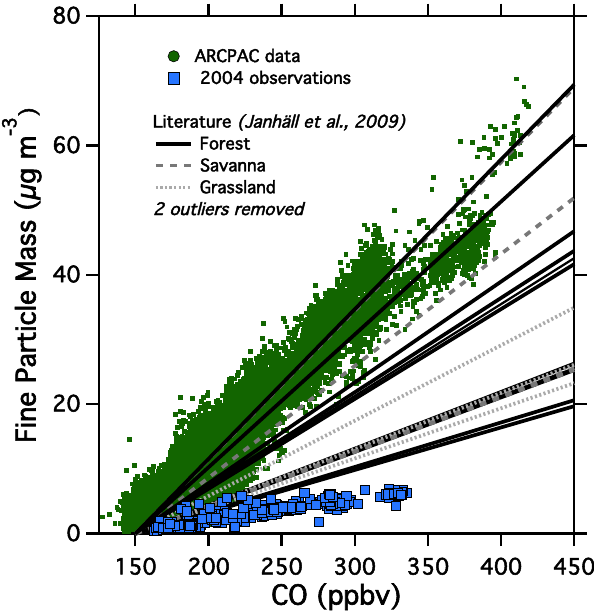
Fig. 13. Particle mass as a function of CO for all data classified as biomass/biofuel burning during ARCPAC (dots). Mass calculated from particle volume measurements and density of 1.36 determined from AMS composition measurements in BB plumes. Squares are data from a BB case in 28 July 2004 in which precipitation scav- enging occurred (de Gouw et al., 2006) with CO values adjusted to intercept the x -axis at 150ppbv to facilitate comparison with ARC- PAC data. Lines are fits to measurements in a variety of prescribed, laboratory, and wild fires as summarized in Janh¨all et al. (2009), except that 2 outliers have been removed and an x-intercept of 150ppbv